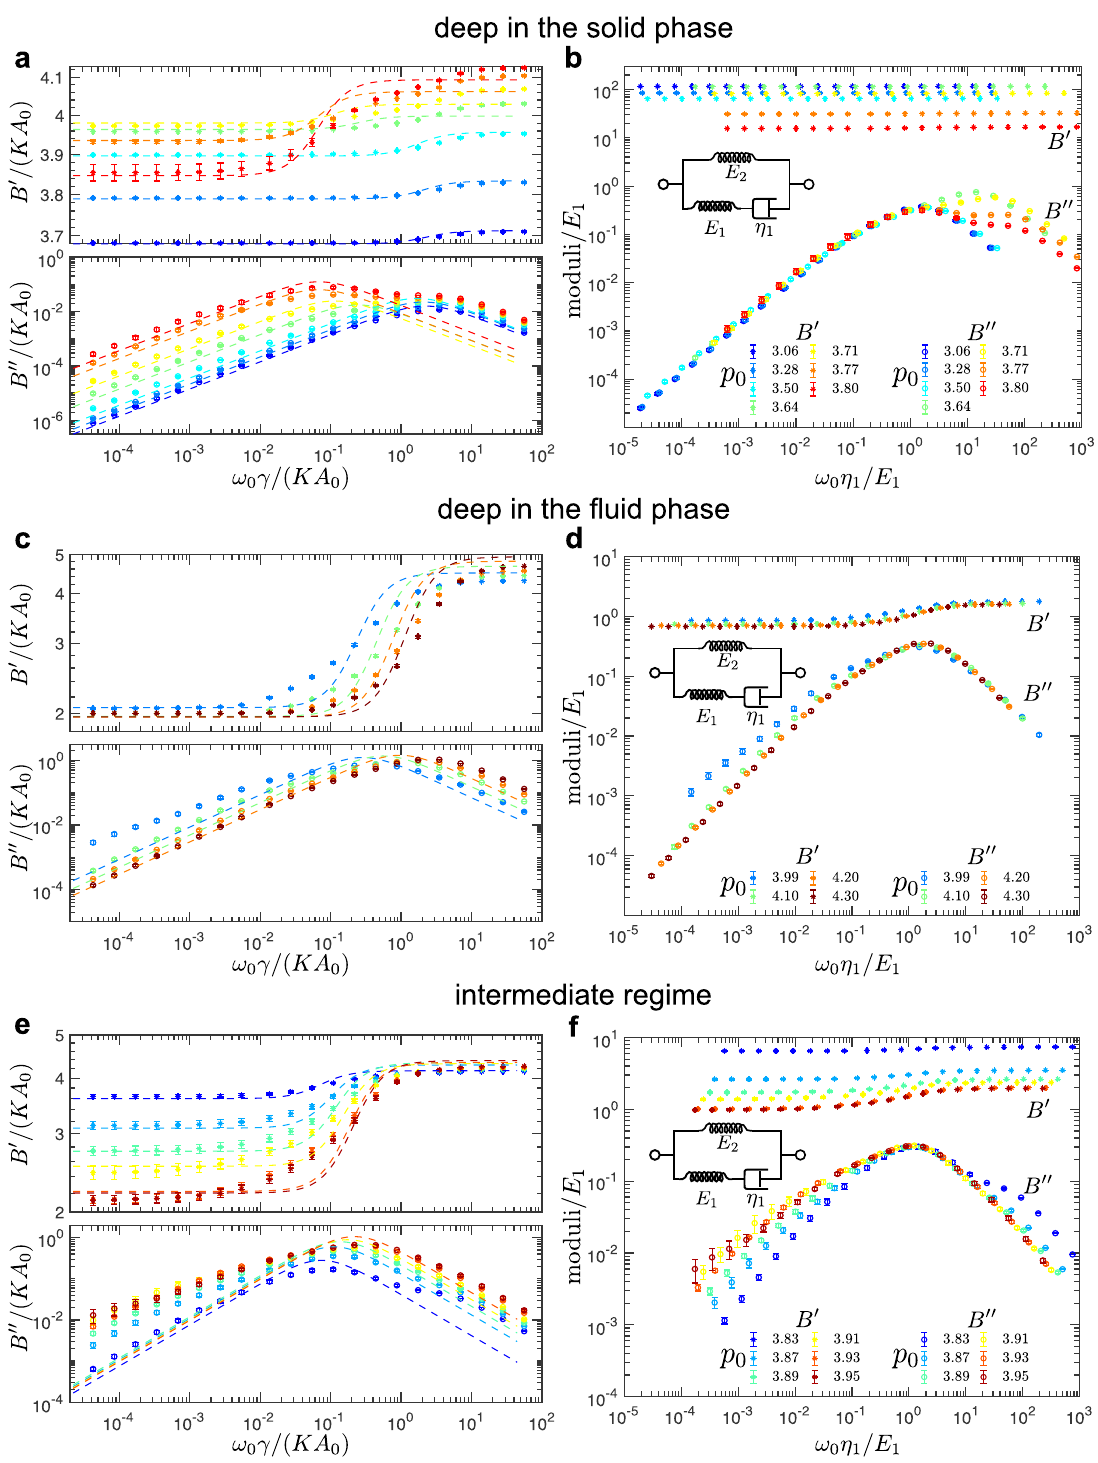
Fig 8. Average storage and loss bulk moduli in the solid and fluid phase for disordered tilings. (a,c) Average storage ( B 0 ) and loss ( B 00 ) bulk moduli as functions of the deformation frequency, ω 0 , for different values of the cell-shape parameter, p 0 , (a) deep in the solid phase and (c) deep in the fluid phase. The error bars represent the standard error of the mean. (b,d) The collapse of the moduli curves for different values of p 0 for (b) the solid phase and (d) the fluid phase. The insets show the representation of the Standard Linear Solid (SLS) model in terms of the springs and dashpots. (e) Average storage ( B 0 ) and loss ( B 00 ) bulk moduli as functions of the deformation frequency, ω 0 , for intermediate values of the cell-shape parameter, p 0 . (f) The collapse of the moduli curves for for intermediate values of the cell-shape parameter, p 0 . Dashed curves in (a,c,e) are the fits based on the SLS model [see Eq (5)]. https://doi.org/10.1371/journal.pcbi.1010135.g008 PLOS Computational Biology | https://doi.org/10.1371/journal.pcbi.1010135 May 19,